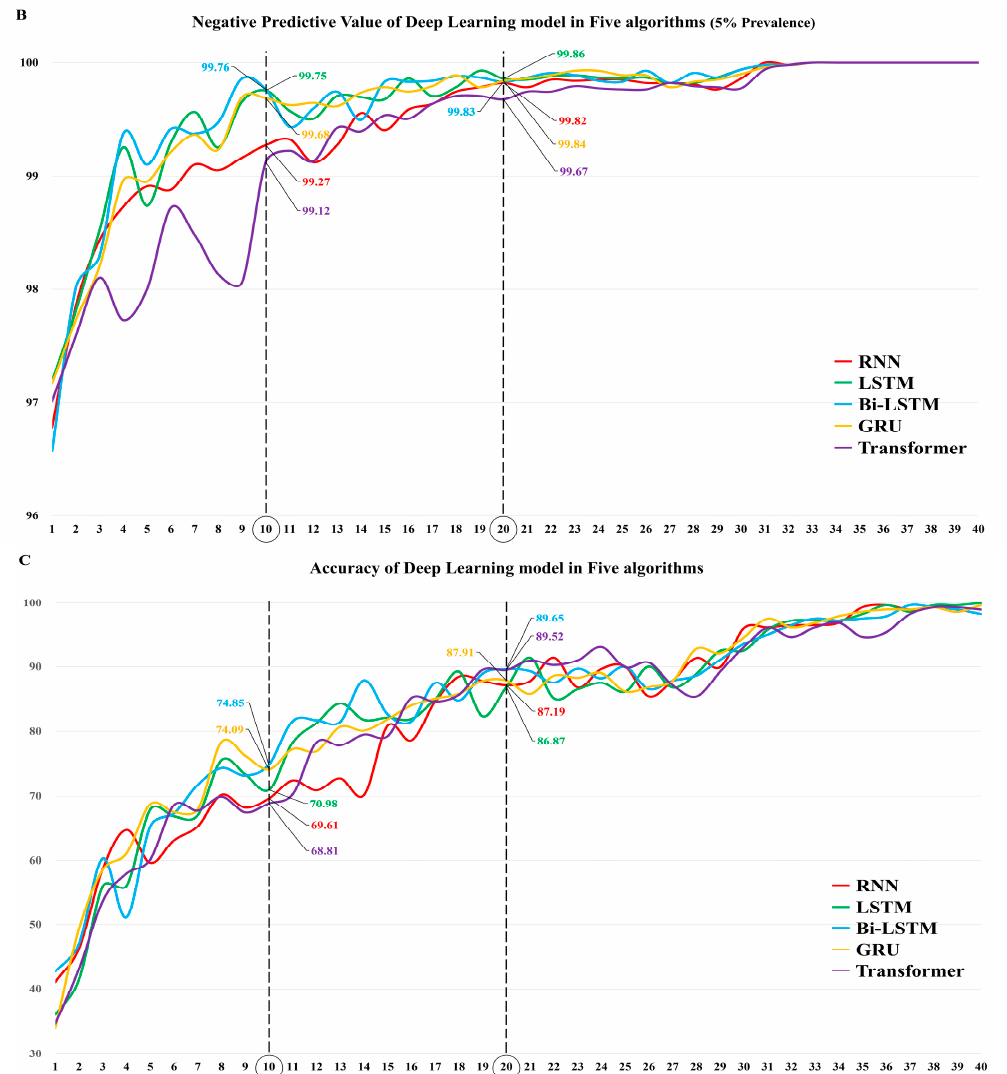
Figure 5. Diagnostic performance affected by the prevalence of 5% of DL models in five different algorithms using the test dataset. ( A ) Positive predictive value of DL model in five algorithms. ( B ) Negative predictive value of DL model in five algorithms. ( C ) Accuracy of DL model in five algorithms. RNN: recurrent neural network; LSTM: long short-term memory; GRU: gated recurrent unit; Bi-LSTM: bidirectional long short-term memory; DL: deep learning.